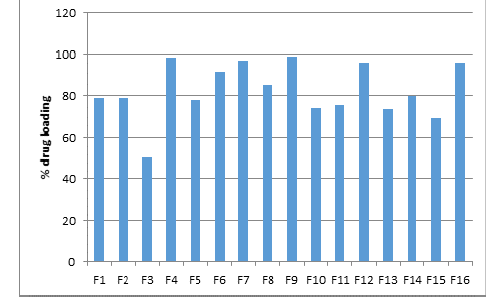
Figure 4. Drug loading of ITZ floating microparticles